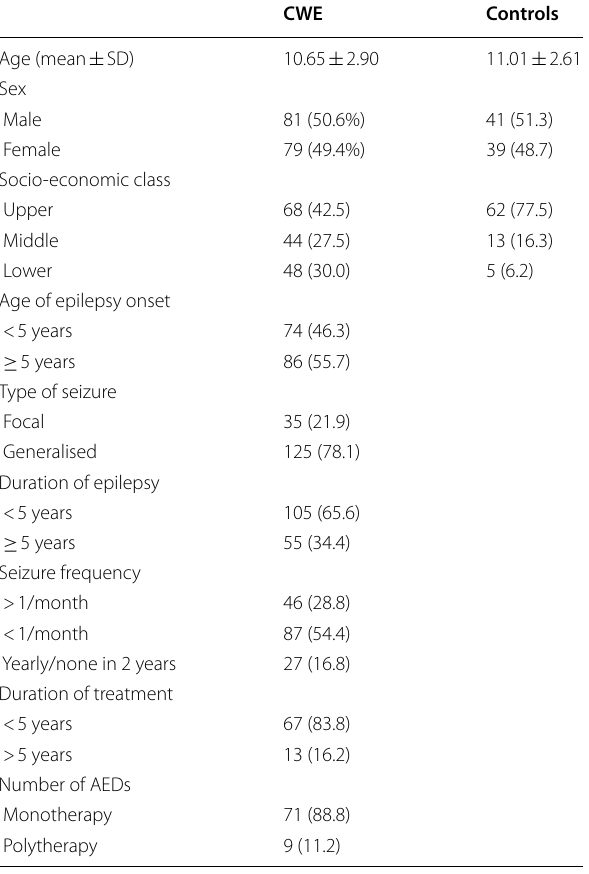
Table 1 Demographic and clinical characteristics of study